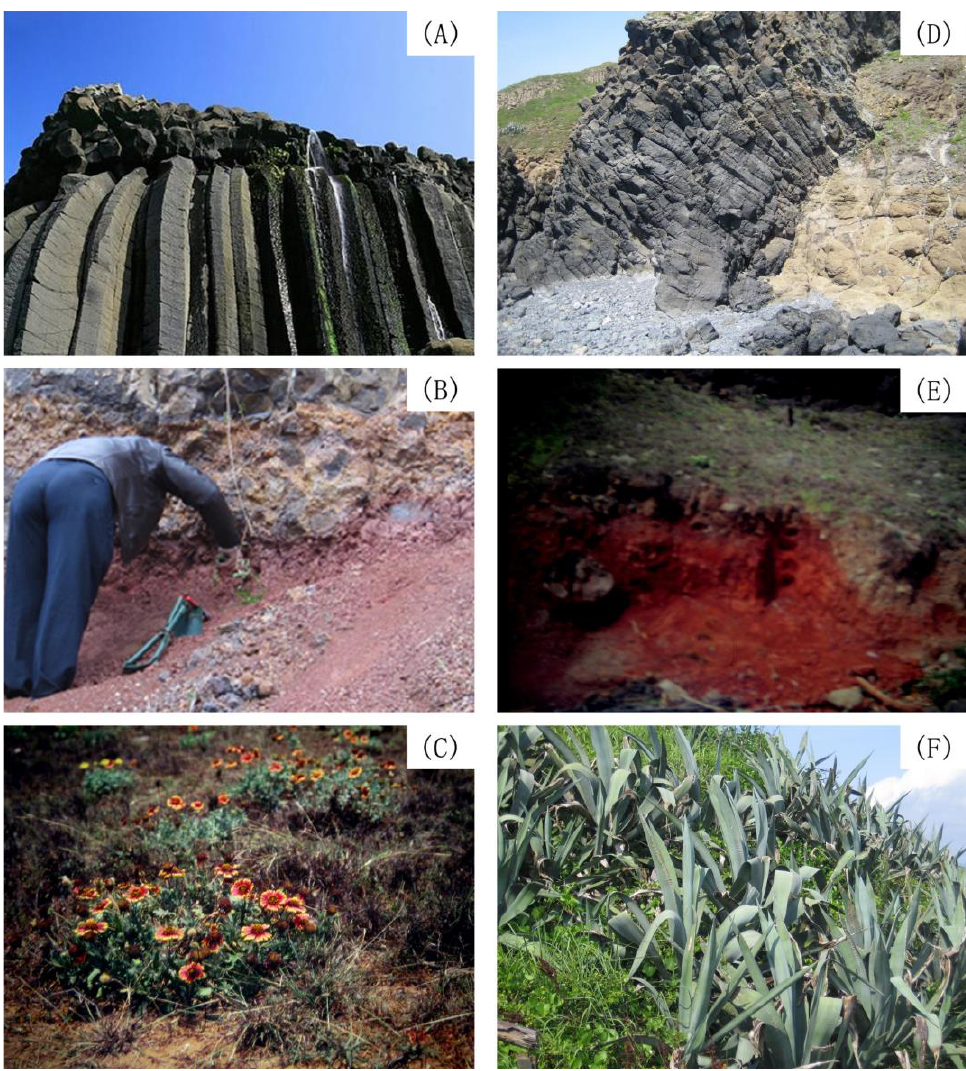
Figure 1. Columnar basaltic eruptions, paleosol structures and vegetation of the Penghu Islands ( A – C ) and Zhangpu volcanic area ( D – F ) (courtesy of https://zh.m.wikipedia.org (22 December, 2022) and https://baike.baidu.com (22 December, 2022)).